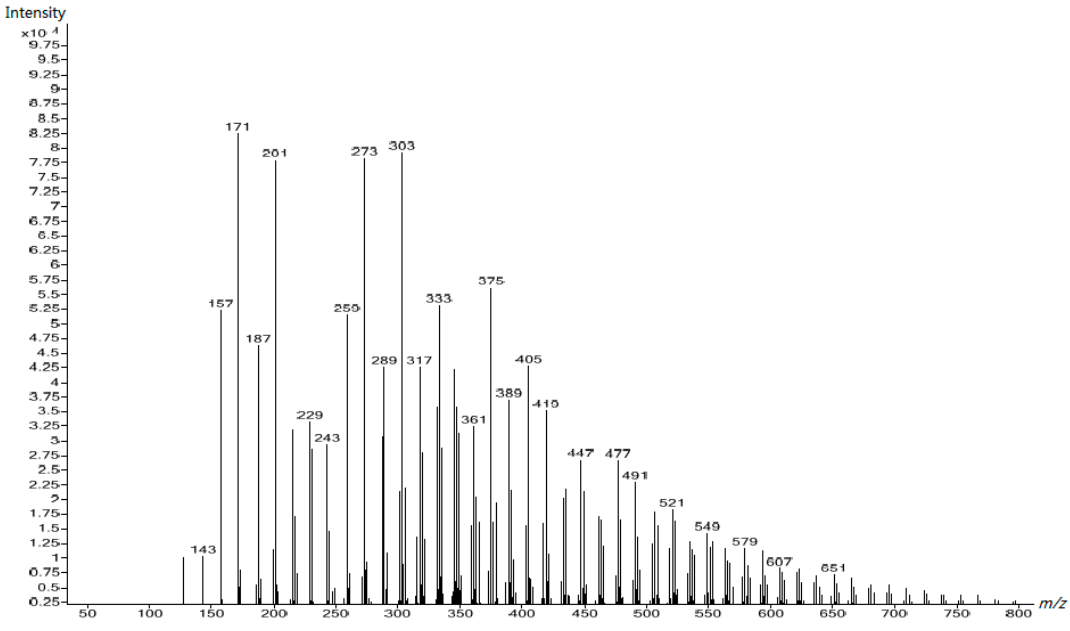
Figure 11. The ESI–MS spectrum of UF-4.